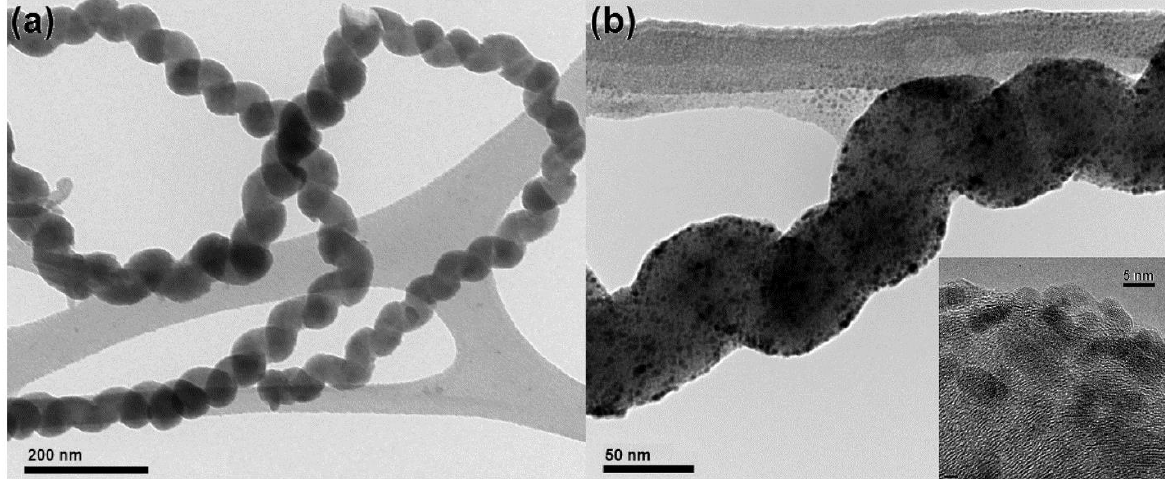
Figure 8. TEM images of ( a ) HCNFs and ( b ) Palladium nanoparticle decorated HCNFs (inset: HRTEM of Pd-HCNFs) ([77], Jia et al .